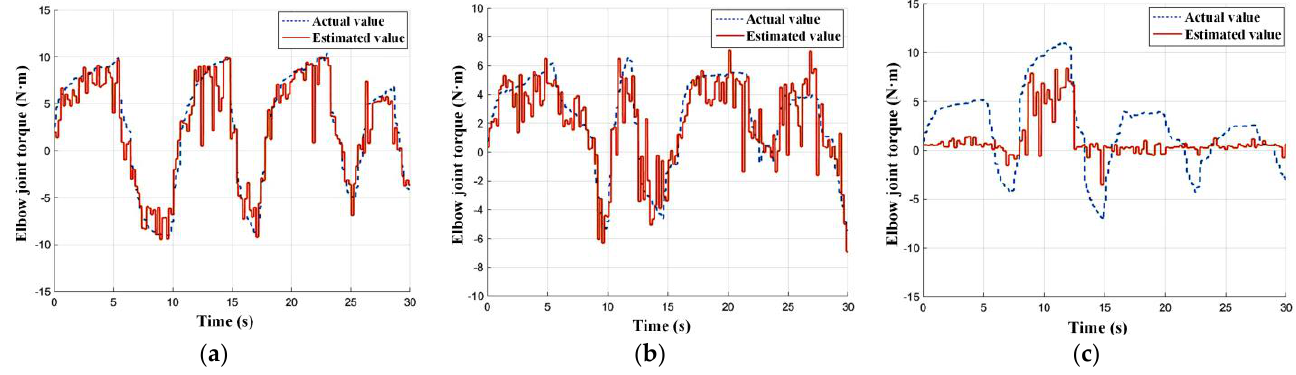
Figure 9. Elbow joint torque estimation results: ( a ) experimental result of Subject 1; ( b ) experimental result of Subject 2; ( c ) experimental result of Subject 3.